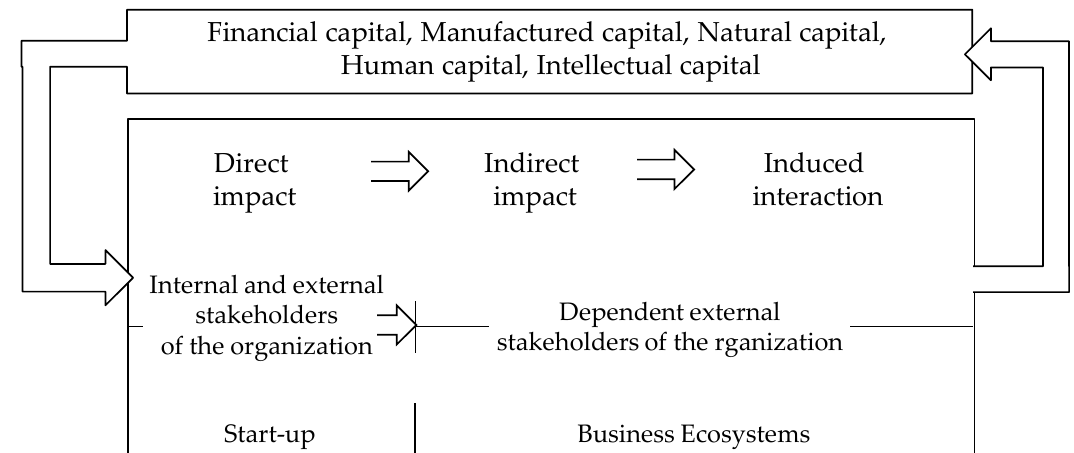
Figure 7. The influence of the entity on the economy in the direct, indirect and induced dimensions. Source: author’s own development.